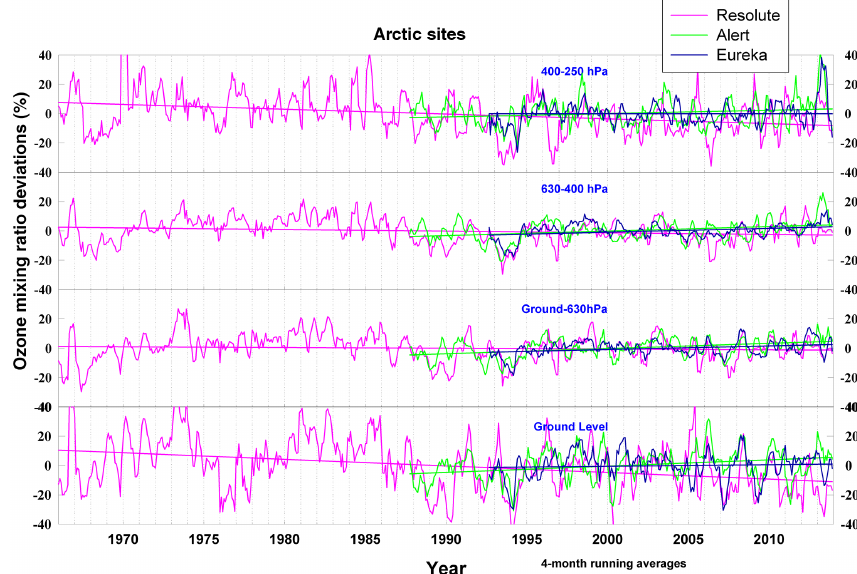
Figure 10. As Fig. 9, for the three Arctic stations. The overall station trend lines (up to 48 years in the case of Resolute) are shown.